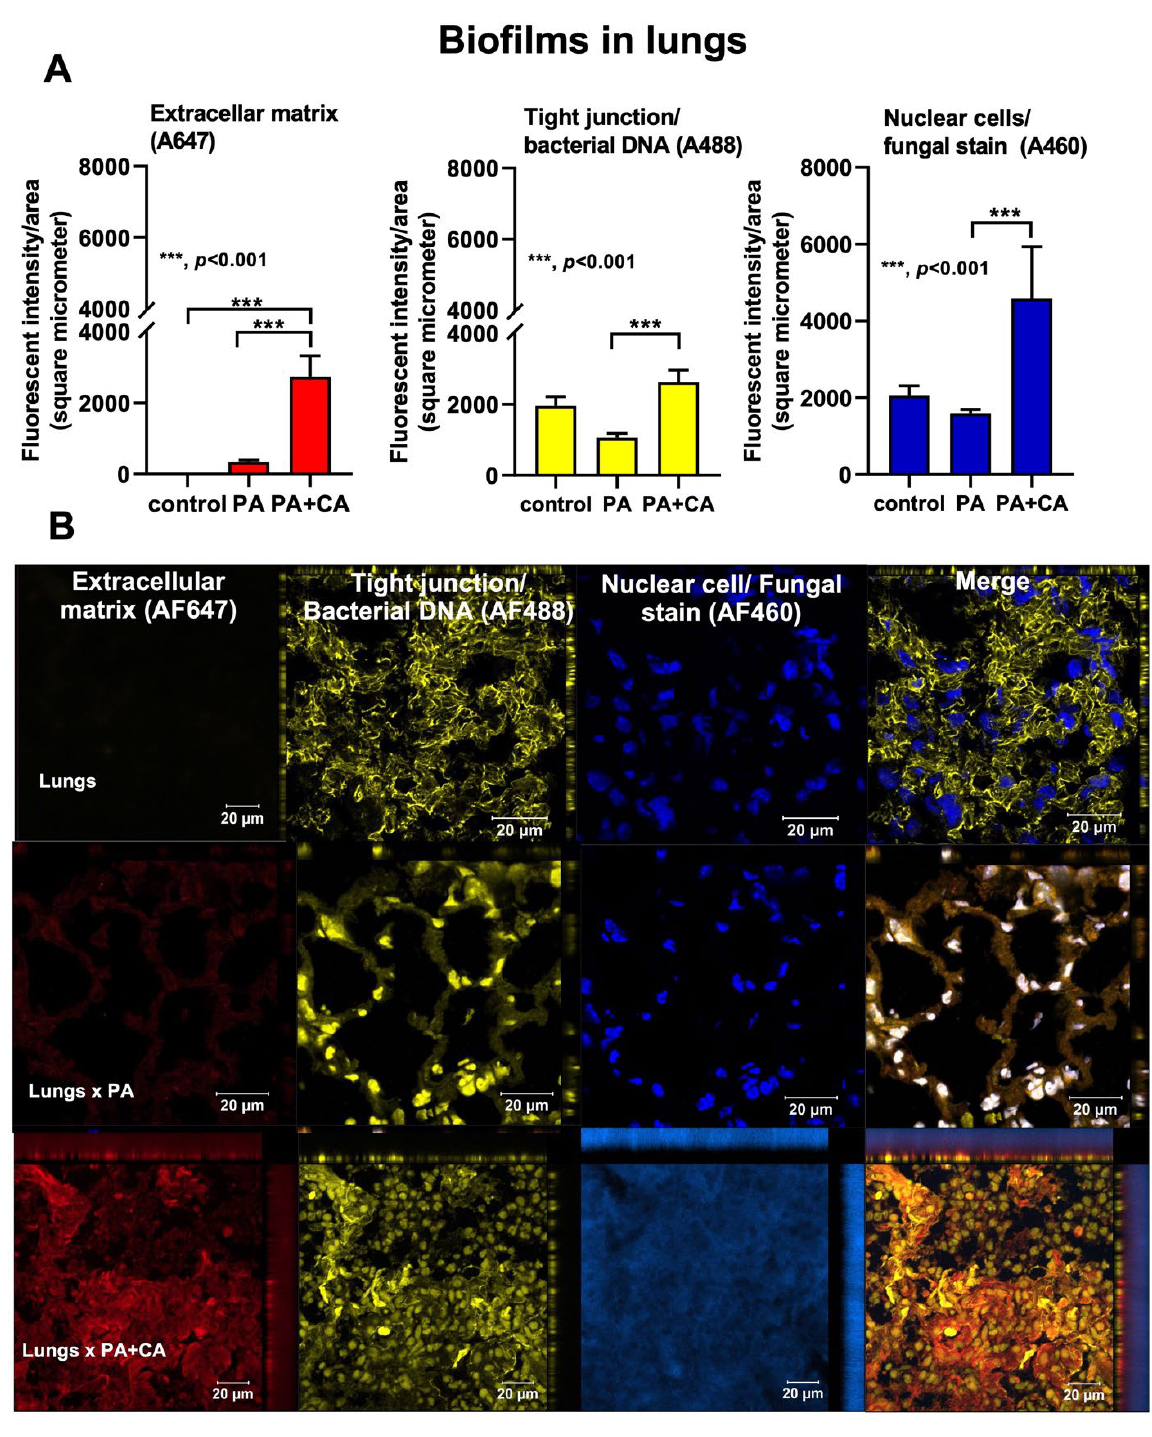
Figure 5. The characteristics of biofilms on mouse lung tissue after the administration of Pseudomonas alone (PA), Pseudomonas with Candida (PA+CA), or control after staining for extracellular matrix (AF467, red), cell tight junction, bacterial DNA (AF488, yellow), and nuclei of host cells and fungi (AF460, blue) as indicated by fluorescent intensities ( A ) and the representative pictures ( B ) ( n = 6–7 per group). Despite being the same color, the linear feature of the tight junction and the smaller size of fungal nuclei compared to the host are used for differentiation (see text).